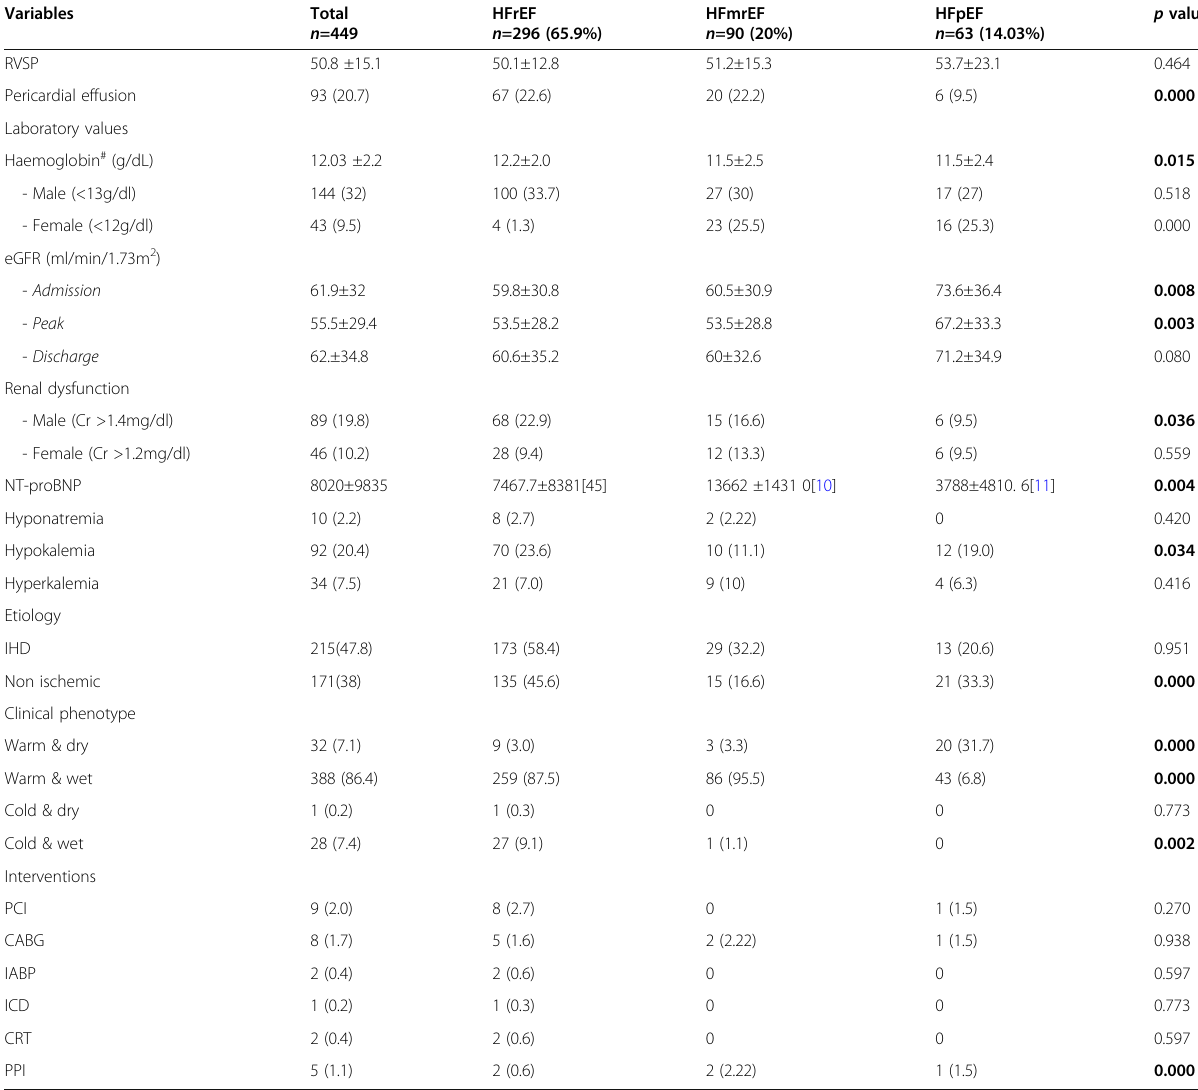
Table 1 Baseline characteristics of patients admitted with heart failure (Continued) Variables Total